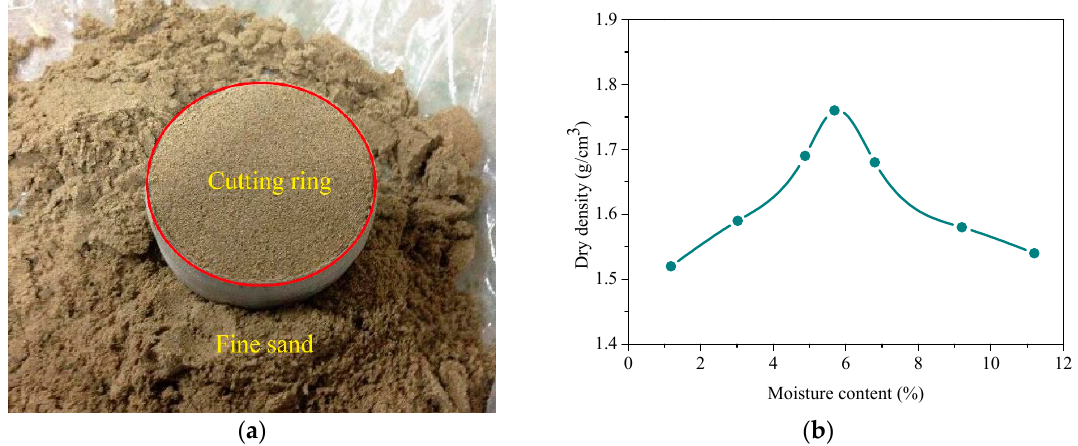
Figure 1. Soil sample: ( a ) fine sand; ( b ) result of heavy compaction test. Table 1. Mechanical properties of the soil sample.